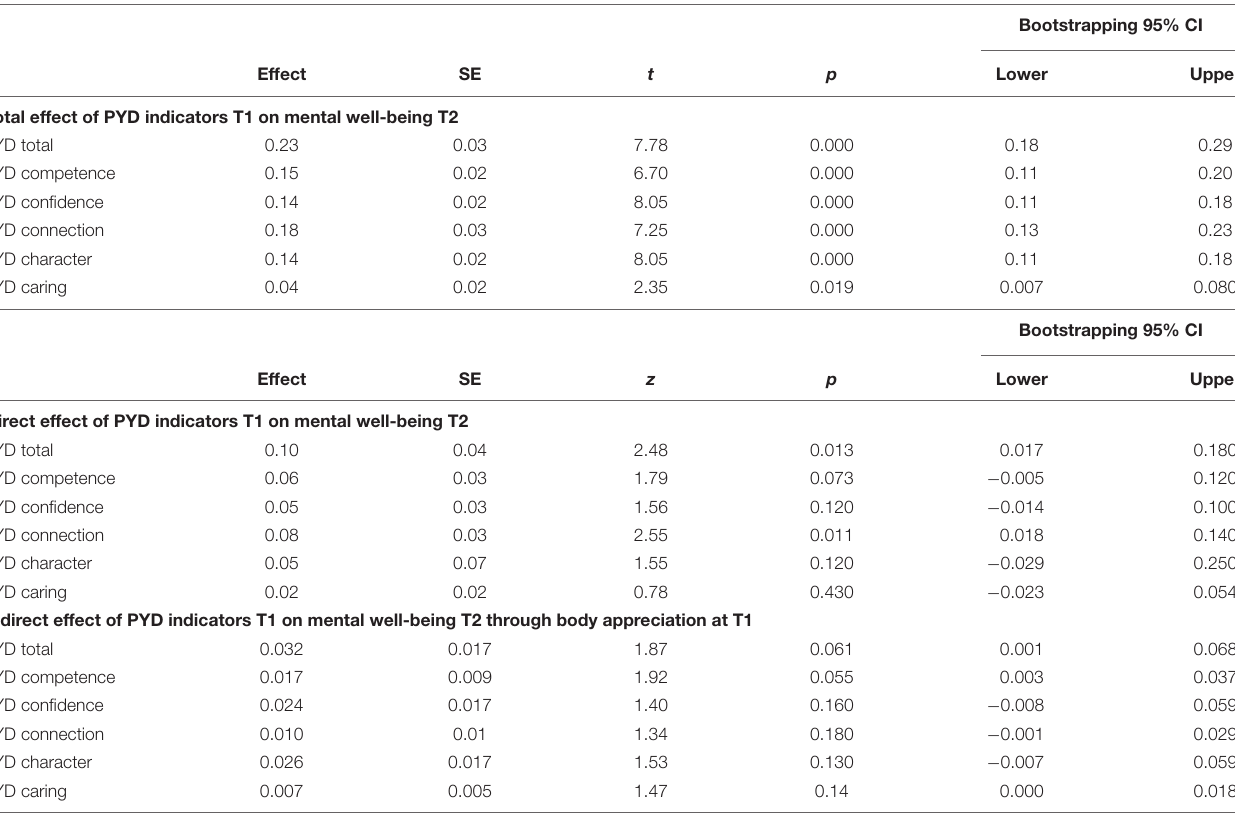
TABLE 4 | Direct and indirect effects from six separate models of PYD indicators at T1 (total and individual) on mental well-being at T2 including body appreciation at